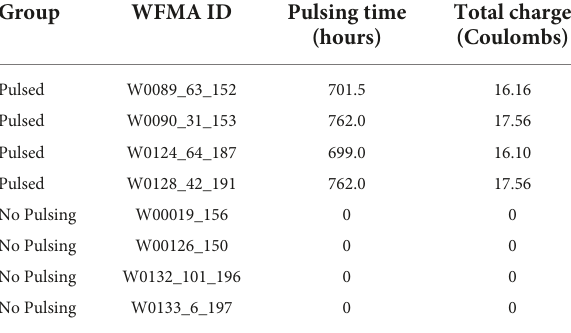
TABLE 1 WFMA IDs and group assignments for pulsing in